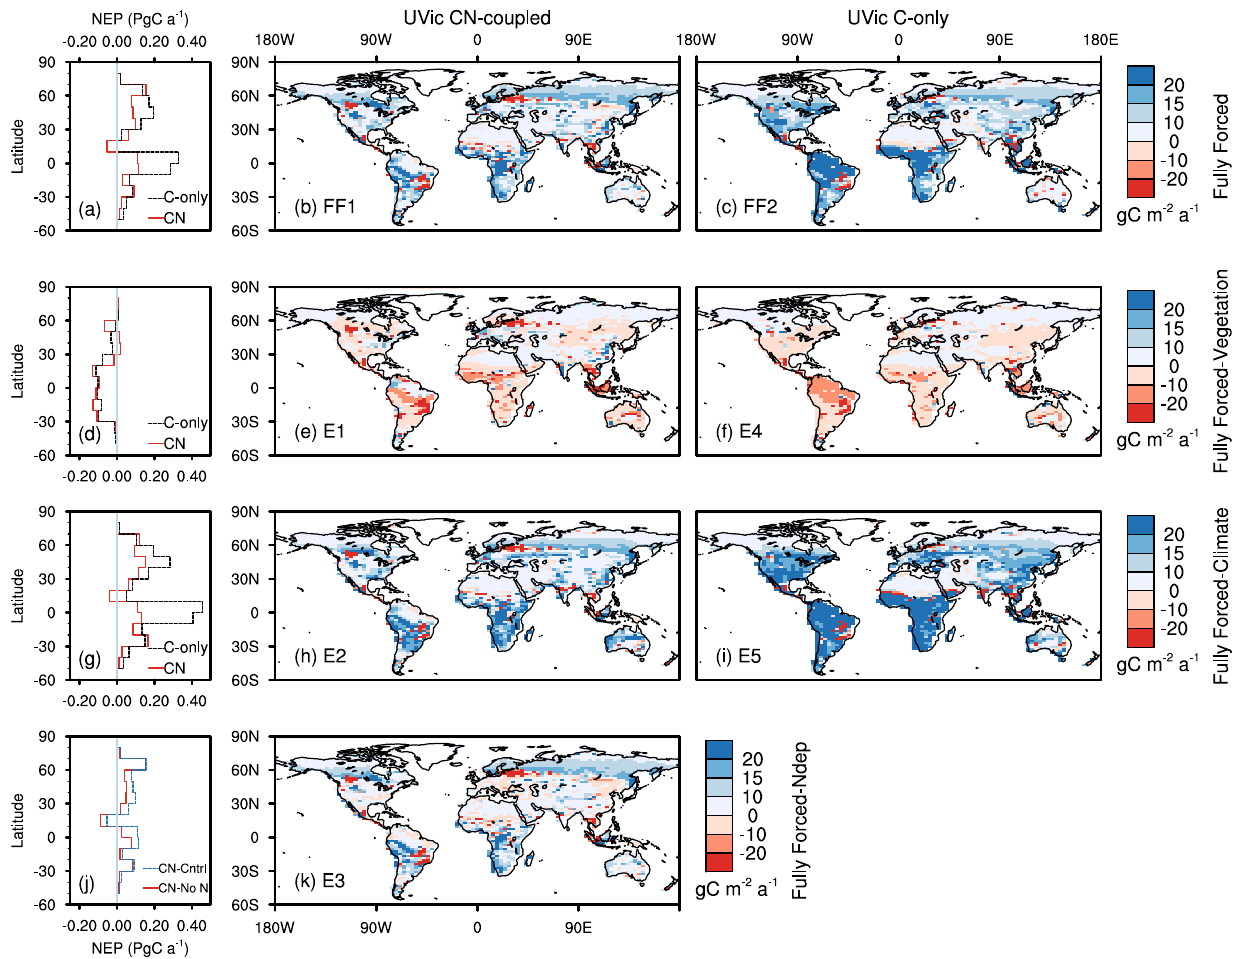
Fig. 9. Mean 1990–1999 Net Ecosystem Production (NEP); positive values indicate a C sink, negative values a C source. Zonal averages of NEP for UVic-CN (solid red) and UVic C-only (dashed black) in 10 ◦ increments (a, d, g) and spatial distribution of NEP for UVic-CN (b, e, h, k) and UVic C-only (c, f, i) . In plot (j) the UVic-CN “Fully Forced-N dep” (solid red, “CN-No N”) is compared to the UVic-CN “Fully Forced” (blue dashed, “CN cntrl”). Four sets of experiments are shown: “Fully Forced” (FF1 and FF2), “Fully Forced-Vegetation” (E1 for UVic-CN and E4 for UVic C-only), “Fully Forced-Climate” (E2 for UVic-CN and E5 for UVic C-only) and “Fully Forced-N dep” (E3). See Table 5 for the description of the